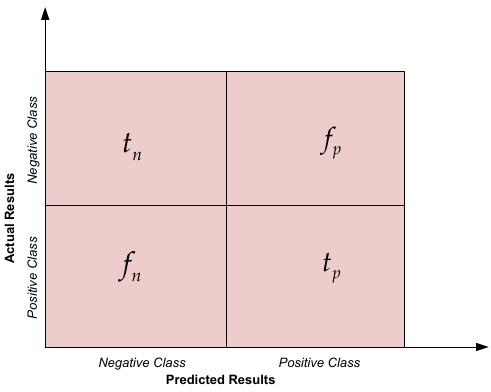
Figure 4. Confusion matrix plot.